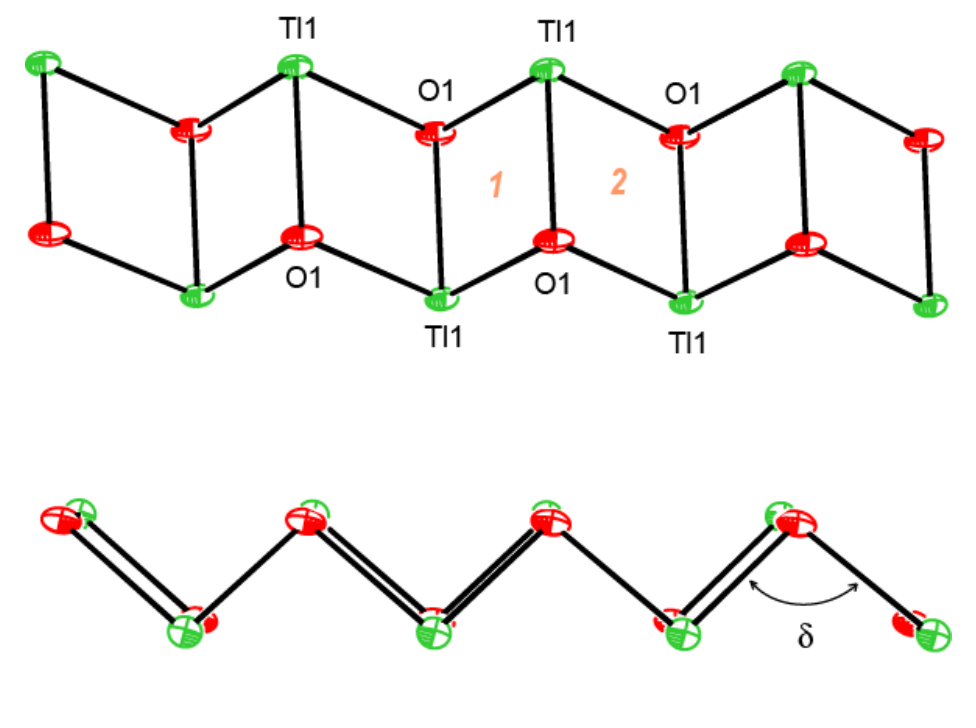
Figure 12. Typical double-stranded “ladder-type” polymeric motif in crystal structures of several TlL: two orthogonal views. The groups L are: monosubstituted-arylcyanoximes, such as 2Cl-PCO − , 2F-PhCO − , 4Br-PhCO − , and heteroarylcyanoximes such as 3PCO − , 4PCO − , BTCO - (from Figure